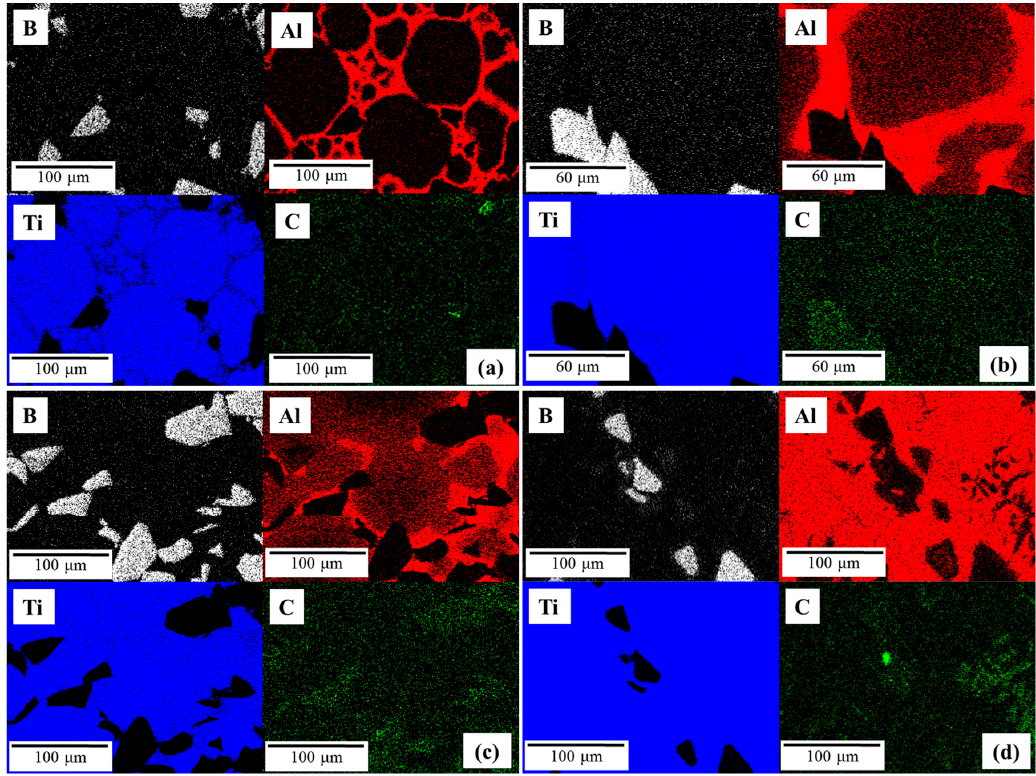
Figure 6. EDS mappings at different manufacturing temperatures: ( a ) 900 °C; ( b ) 1000 °C; ( c ) 1100 °C and ( d ) 1400 °C.